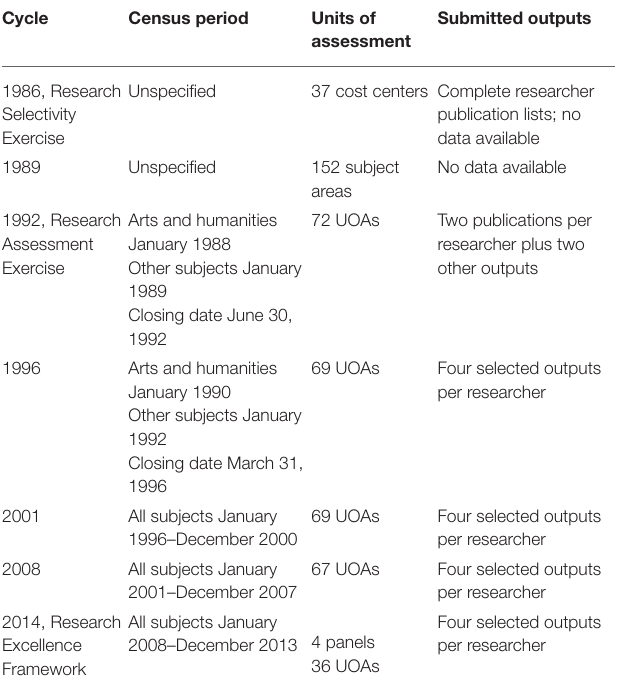
TABLE 1 | Summary information for the timetable and census period of UK research assessment